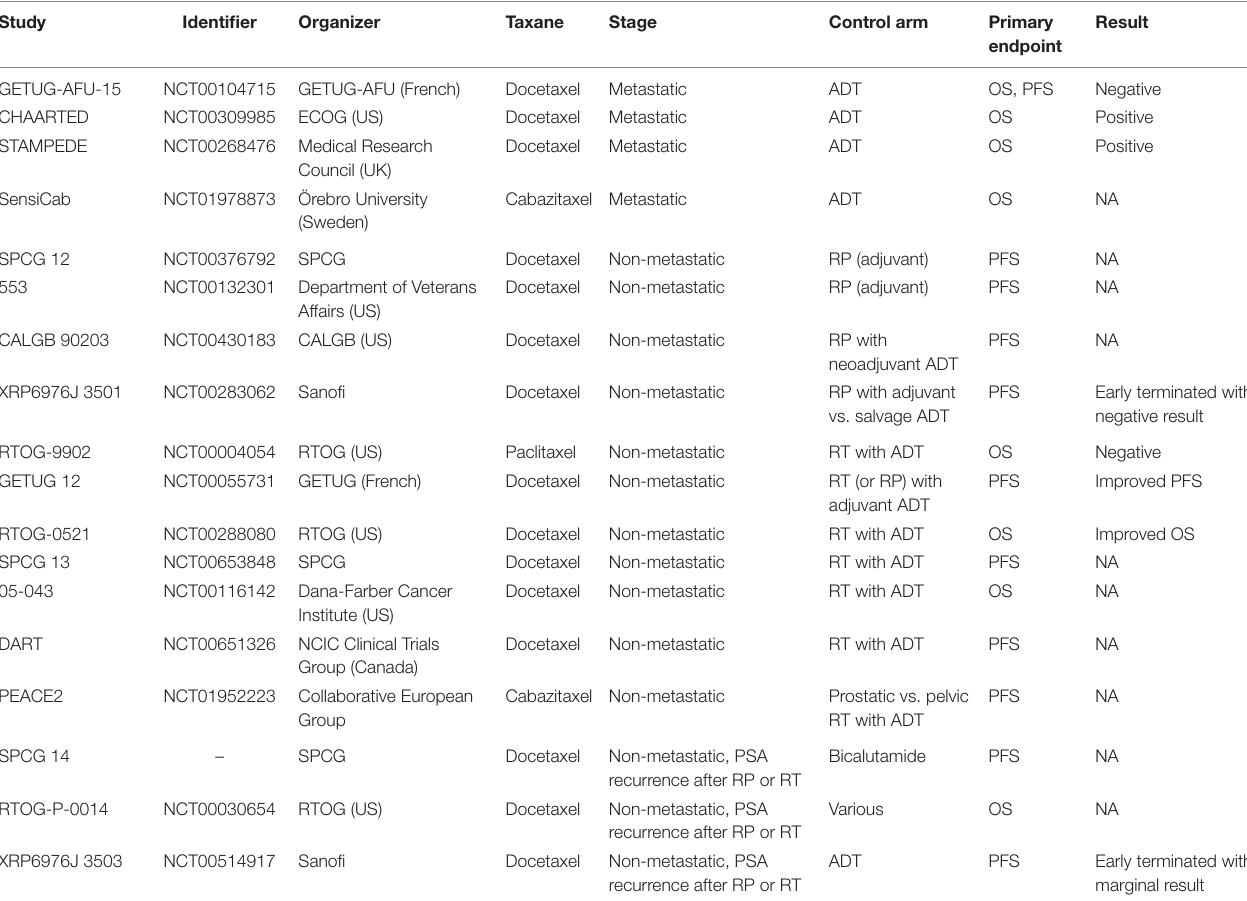
TABLe 2 | Phase 3 clinical trials examining taxane chemotherapy for hormone-naïve prostate cancer.